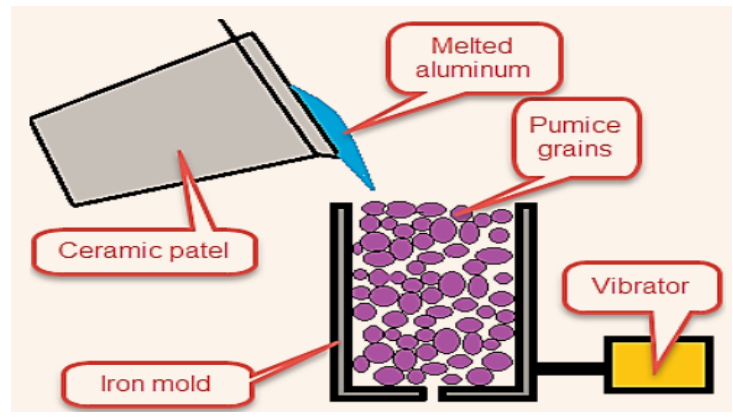
Figure 7: Almond granulation pumice.